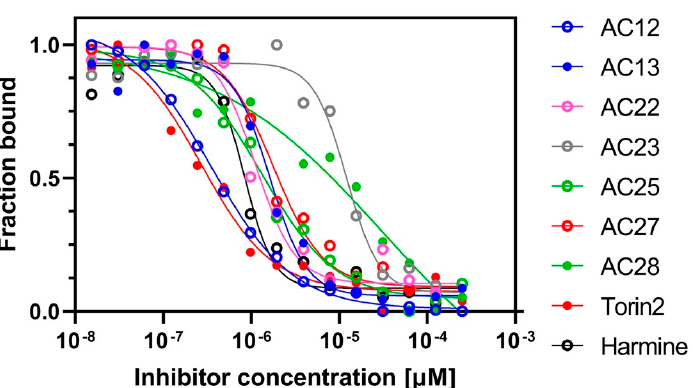
Figure 2. Direct binding determined by MST. Changes in normalized fluorescence signal upon temperature jump at different inhibitor concentrations were converted to inhibitor fraction bound and plotted against concentration. The average of five measurements for each inhibitor concentration is shown. Standard deviation bars are omitted for clarity. The Hill equation was fit to the experimental data. Table 1. The dissociation constant (Kd) and inhibitory constant (Ki) values determined for the stud- ied compounds and DYRK1A in MST and Cook assays, respectively. Compound